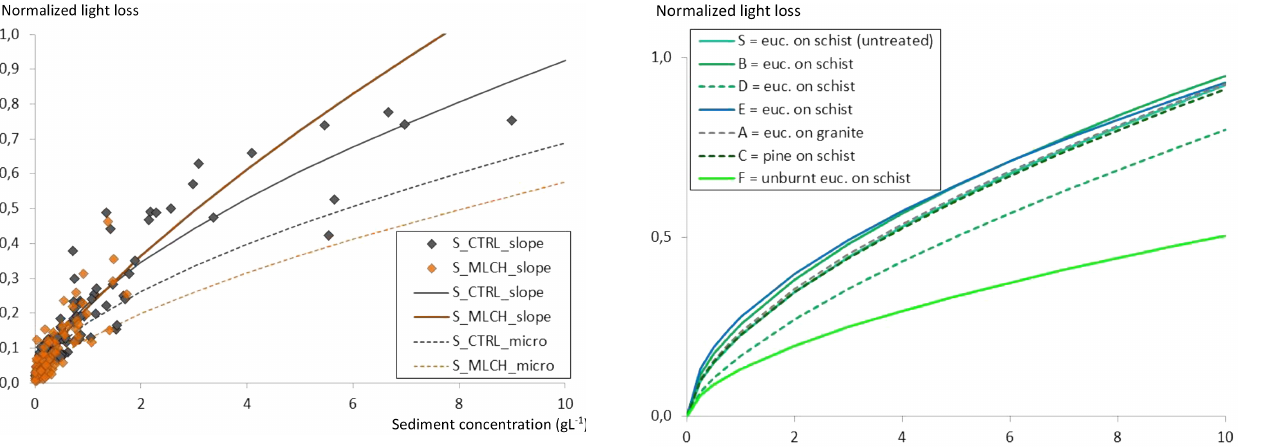
Figure 4. Relationships of post-fire sediment concentration with normalized light loss at the slope scale for two treatments at study site S (symbols), and best-fitting power functions at the slope as well as micro-plot scale (lines) (see Tables 2 and 3). S_CTRL_slope/micro: untreated; S_MLCH_slope/micro: mulching with forest residues.